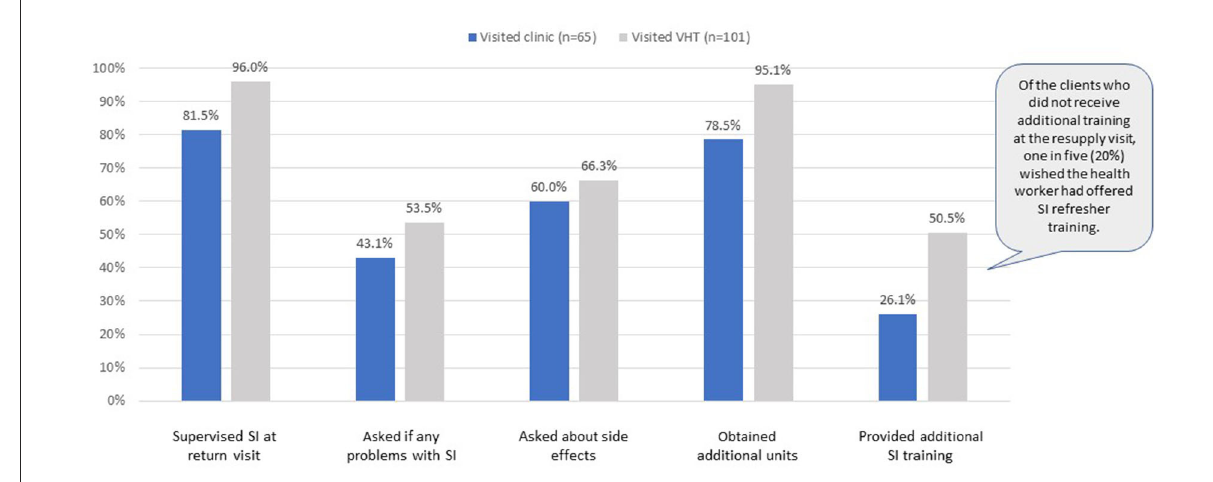
FIGURE2 Experience at resupply visit.